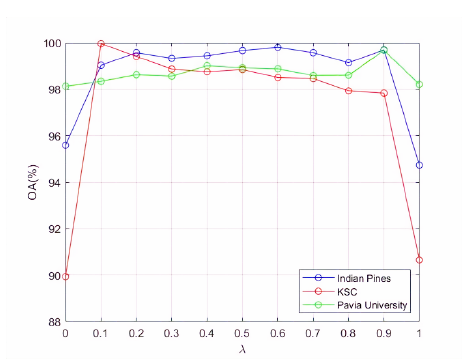
Figure 4. Overall classification accuracy versus the sampling weight parameter ( λ ) The same initial training set (L), unlabeled pool (U), testing set (T), number of iterations (it), and batch size (m) are considered for all AL algorithms.